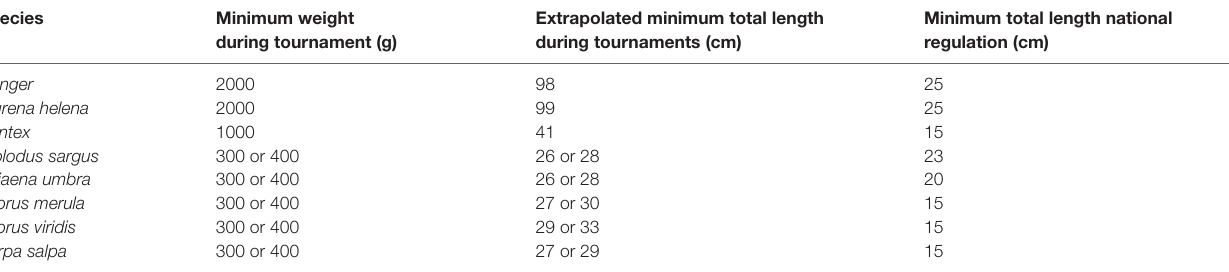
The minimum total length limit for marine spearfishing tournaments has been extrapolated according to the minimum weight limit and the available weight-length tool on www. fishbase.org. Results are shown only for most representative